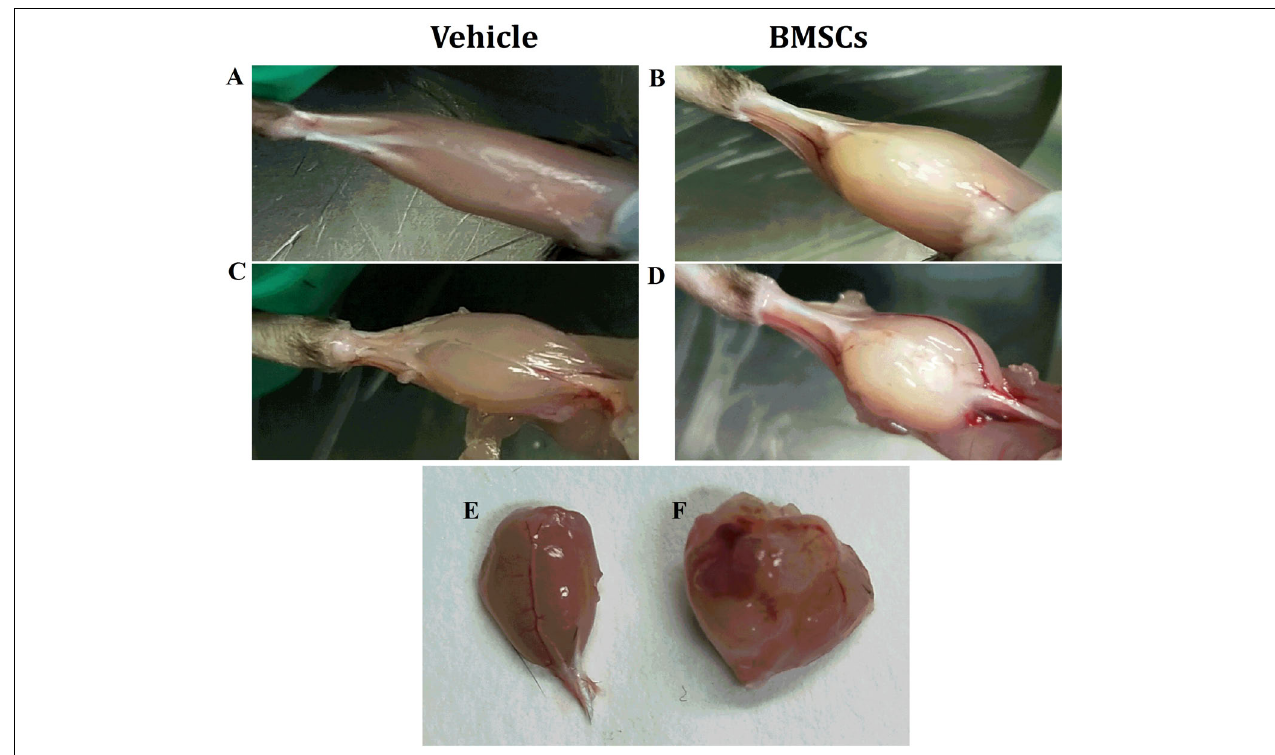
FIGURE 2 | Macroscopic appearances of GMs after BMSCs were treated. (A) Vehicle treated GMs at 24 days post-injury; (B) BMSCs treated GMs at 24 days post-injury; (C) Vehicle treated and fascia stripped GMs at 24 days post-injury; (D) BMSCs treated and fascia stripped GMs at 24 days post-injury; (E) harvested GMs with vehicle treated at 24 days post-injury; (F) Harvested GMs with BMSCs treated at 24 days post-injury; Irregular lumps were found in the BMSCs treated mice other than the vehicle treated